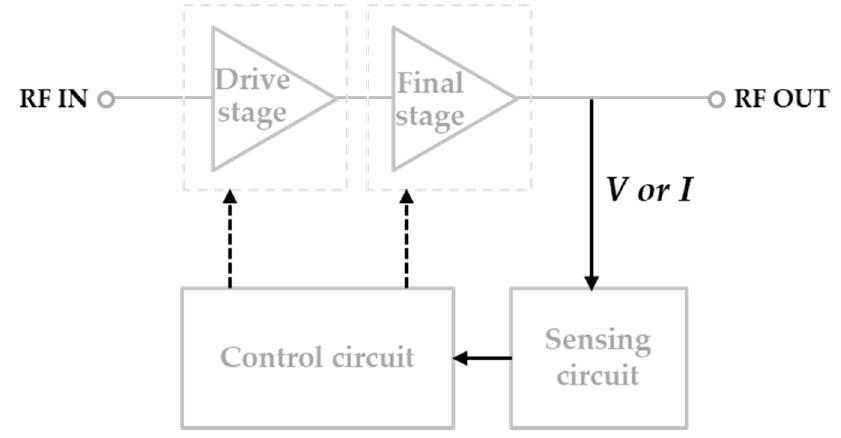
Figure 2. Typical closed-loop protection scheme.